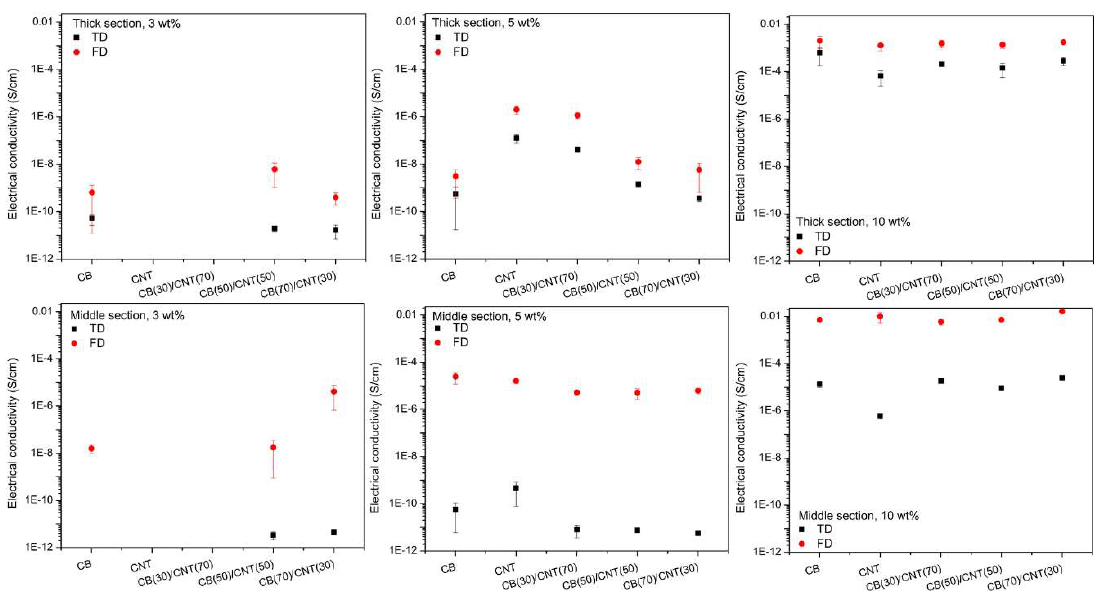
Figure 3. The σ for both the thick and middle sections of microparts which were molded from different carbon filled PS nanocomposites. The measurements were conducted with respect to the TD and FD, respectively.